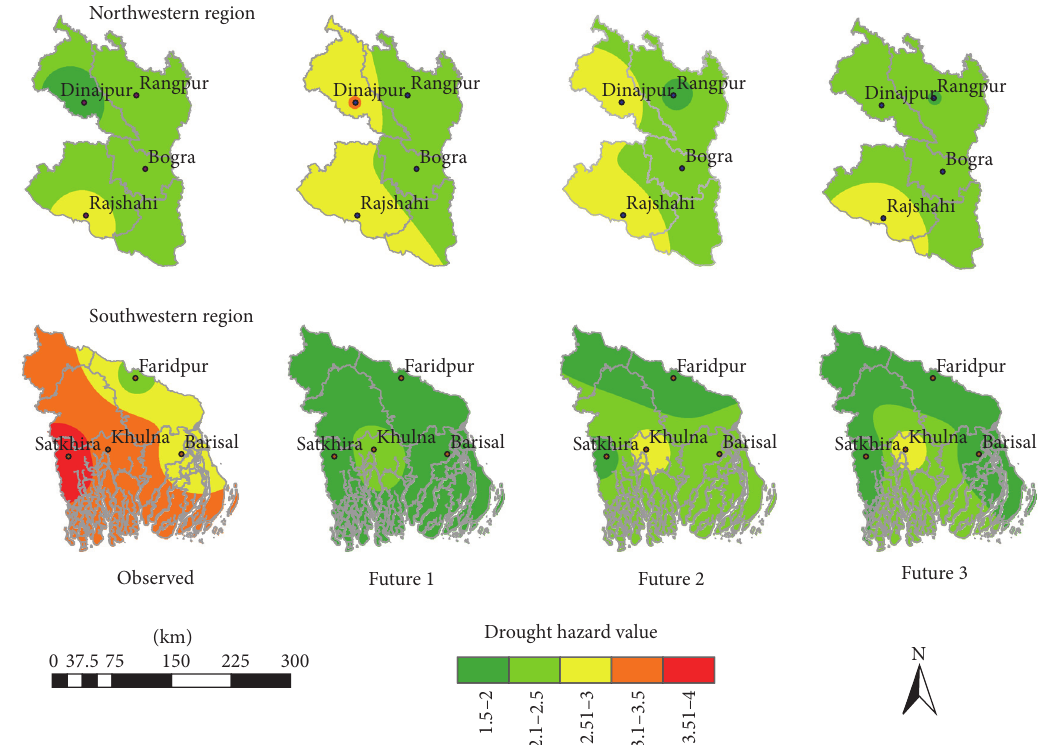
Figure 7: The spatial distribution maps show drought hazard during the Boro paddy growing season of western Bangladesh for future period (2041–2070) relative to the observed period (1984–2013). Three GCMs denote future 1 (CGCM3.1 GCMs), future 2 (FGOALS-G1.0 GCMs), and future 3 (HadGEM1 GCMs) model,